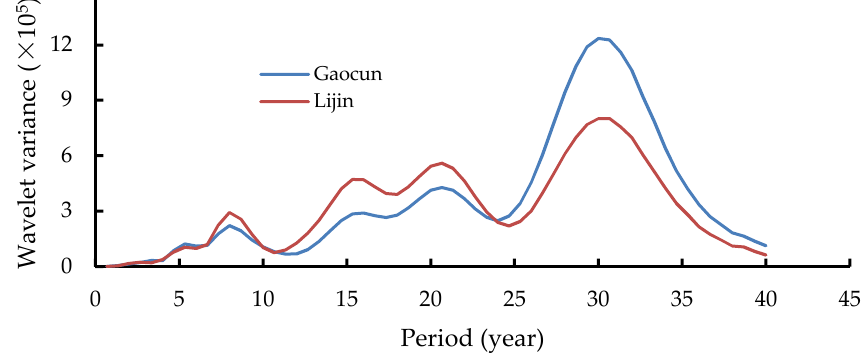
Figure 13. Wavelet variances of streamflows at Gaocun and Lijin in the downstream reaches.